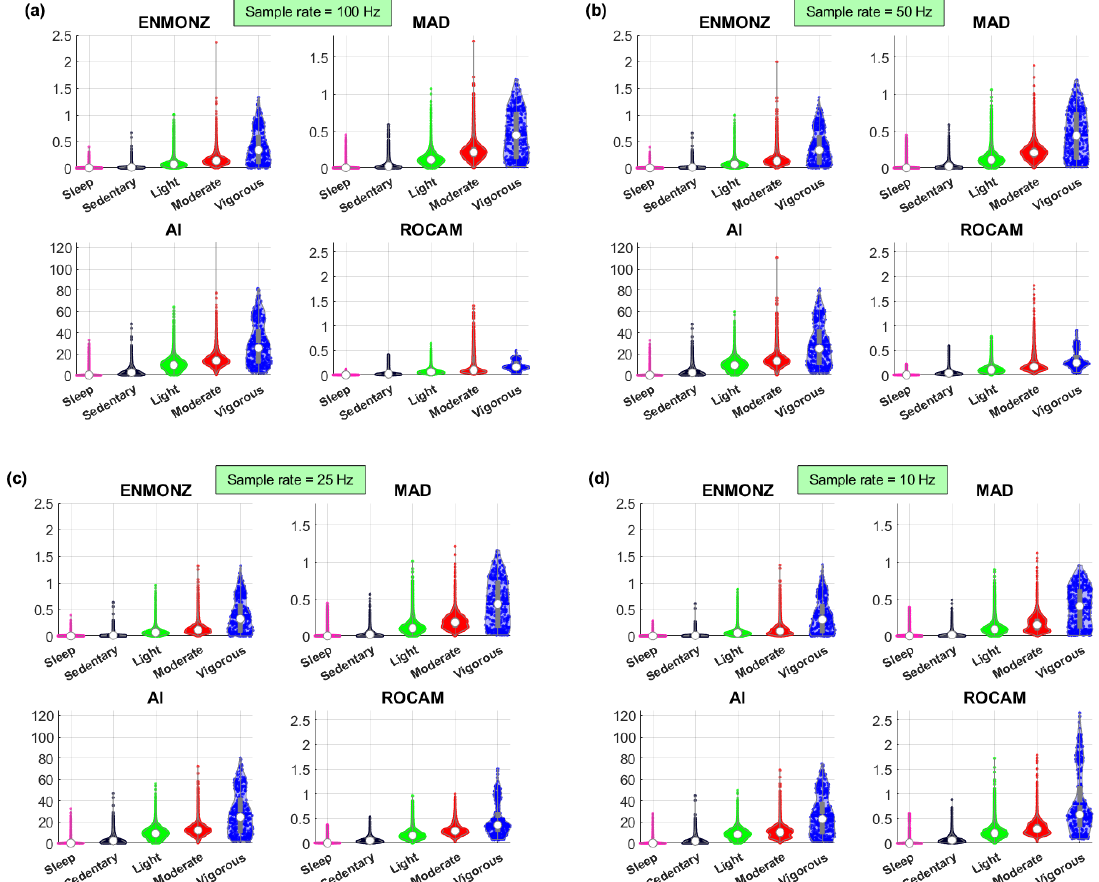
Figure 2. Violin plots to visually illustrate the differences in the acceleration summary measures with the CAPTURE-24 data sampled at ( a ) 100 Hz (original raw data); down-sampled at ( b ) 50 Hz; ( c ) 25 Hz; and ( d ) 10 Hz. Within the violin plot, the circular dot indicates the median. For all acceleration summary measures, the results are presented in gravitational units (g). We have standardized the scale for each of the acceleration summary measure in order to facilitate visual comparisons across the different sample rates.